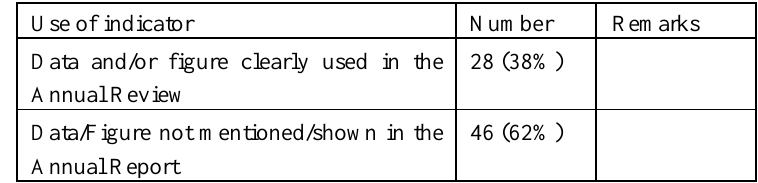
Table 4: Use of the indicators in the annual report of 1996/97 Use of indicator Number